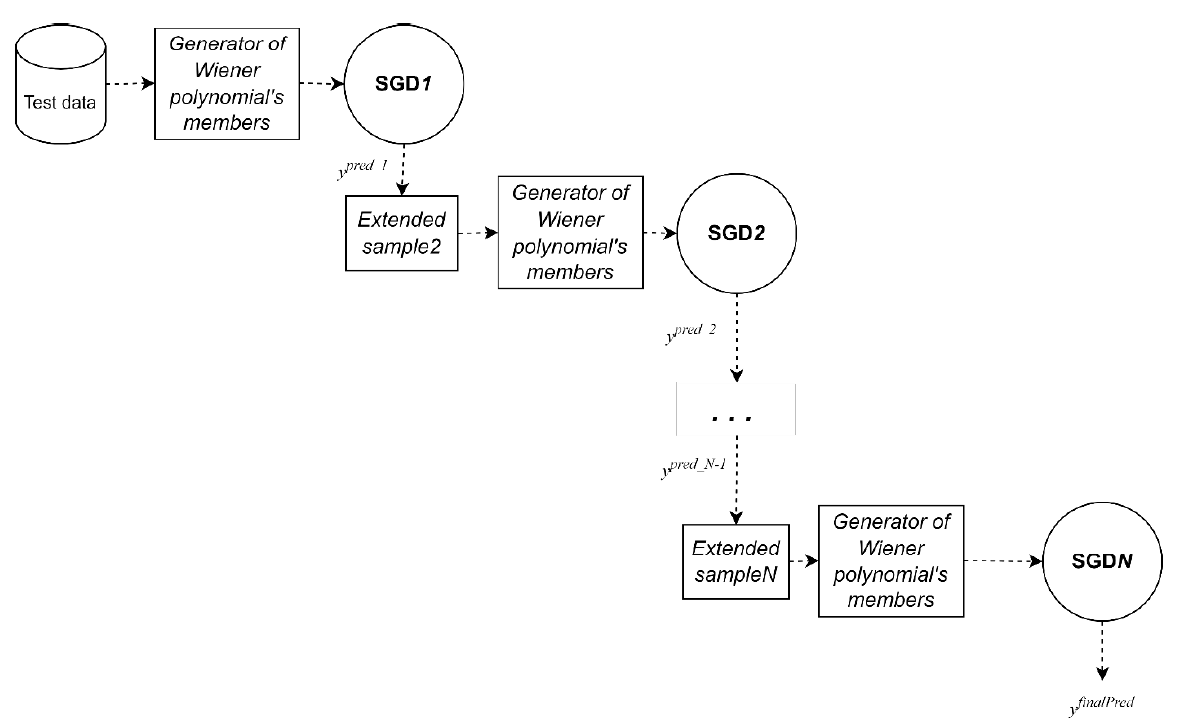
Figure 3. Architecture of the proposed ensemble scheme using Wiener polynomial and SGD: (ap- plication/test